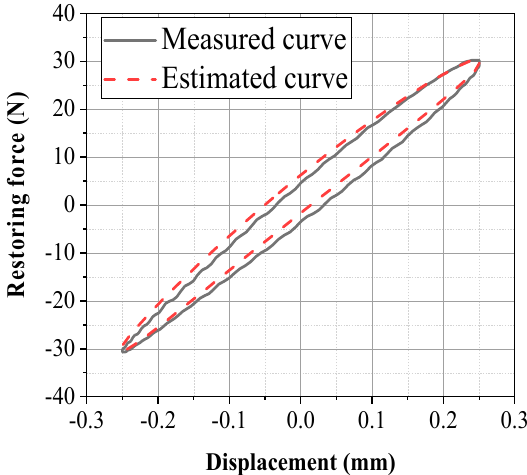
Figure 13. Comparison between the measured curve and estimated curve (vibration amplitude = 0.350 mm, frequency = 10 Hz).